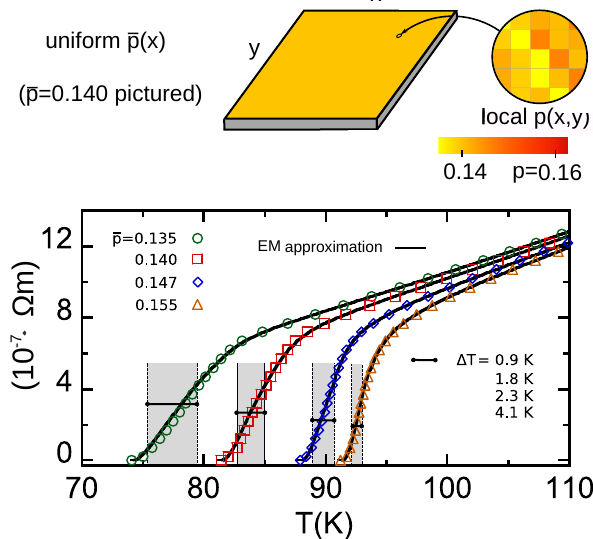
Figure 1. Electrical resistivity ρ versus temperature T obtained for YBa 2 Cu 3 O δ (YBCO) films with a single, uniform value for the nominal doping level p , including the case with negligible T c nanostructuration (or maximum- T c doping, p = 0.155, in which T c saturates near its maximum value and the T c disorder is negligible) and various cases in which the p value corresponds to significant T c nanostructuration (see Section 4 for details). The data points correspond to the finite-element computations, and the continuous lines to the analytical effective-medium (EM) equations.The shaded gray region signals the operational temperature range ∆ T (in which ρ is strongly dependent and linear in T ). In the upper drawing we illustrate the simulated sample and setup, also including a zoom at smaller length scales, imaging the spatial variation of the local doping level p ( x , y ) (each p ( x , y ) monodomain has typical size (30 nm) 2 and the distribution is Gaussian around the average p (x), see main text for